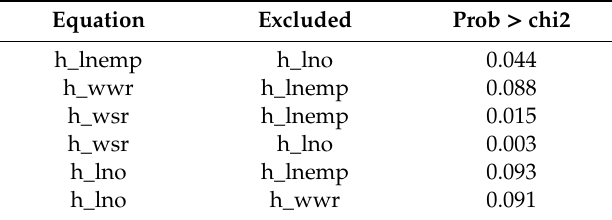
Table 10. Granger causality test results of pollution